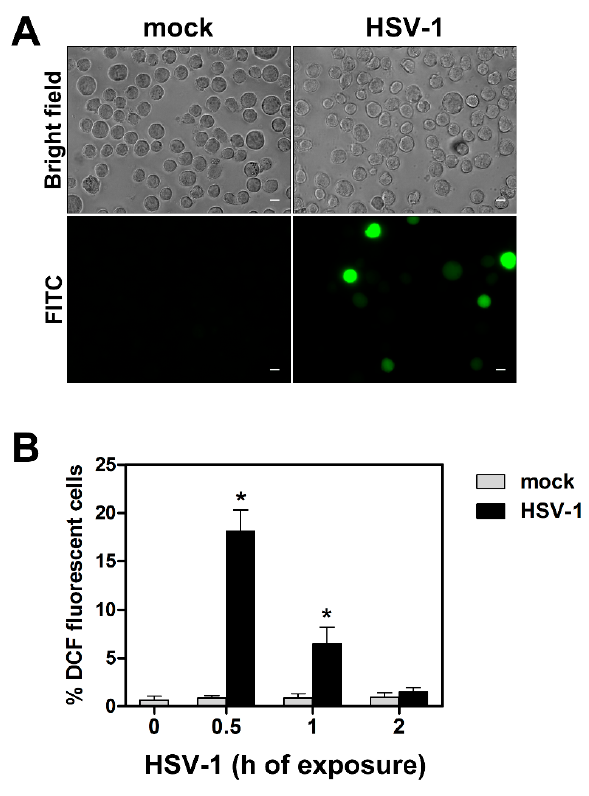
Figure 4. ROS production in THP-1 cells exposed to HSV-1. Cells were preloaded with DCFH-DA 10 µ M, infected with HSV-1 and monitored for ROS production as described in Figure 1. ( A ) Brightfield (total cells) and FITC channel (ROS positive cells) from THP-1 cells infected or mock-infected with HSV-1, MOI 50, for 0.5 h. Digital images were captured by a 40 × objective (Zeiss Axio Observer Z1 microscope). Scale bar = 10 µ m. ( B ) % of DCF fluorescence positive cells (mean + S.D.) obtained by fluorescence microscope analysis. Frames randomly captured by 20 × objective from two separate experiments (2 frames each, total n = 4) were evaluated. * p < 0.001. vs control (h 0). Viruses 2019 , 11 , x FOR PEER REVIEW